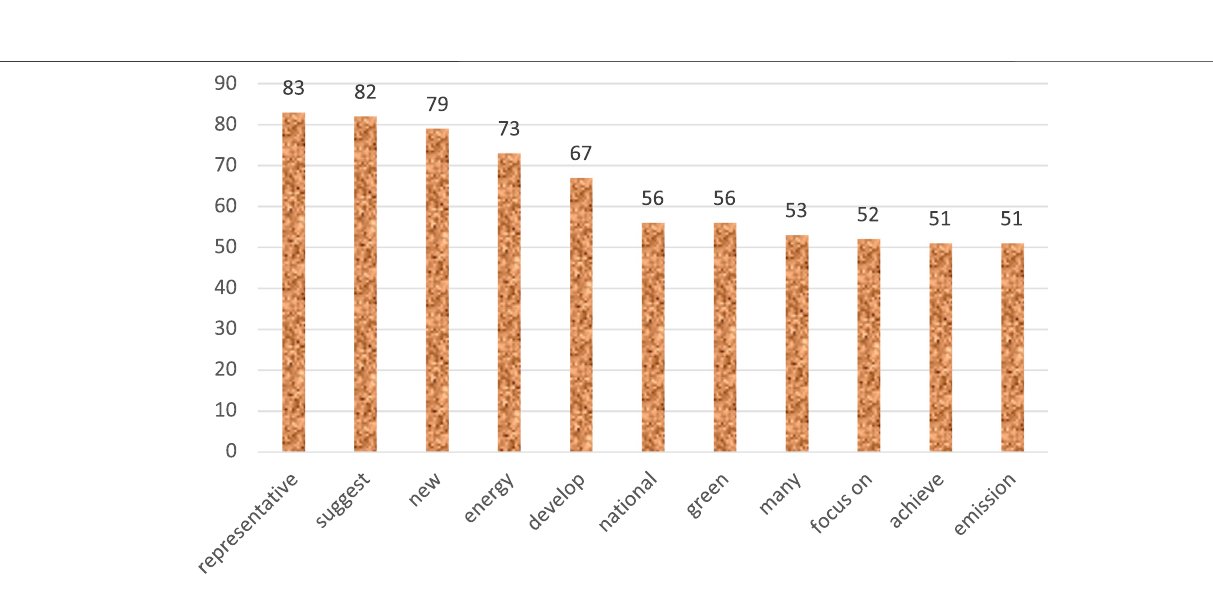
Frontiers in Environmental Science |